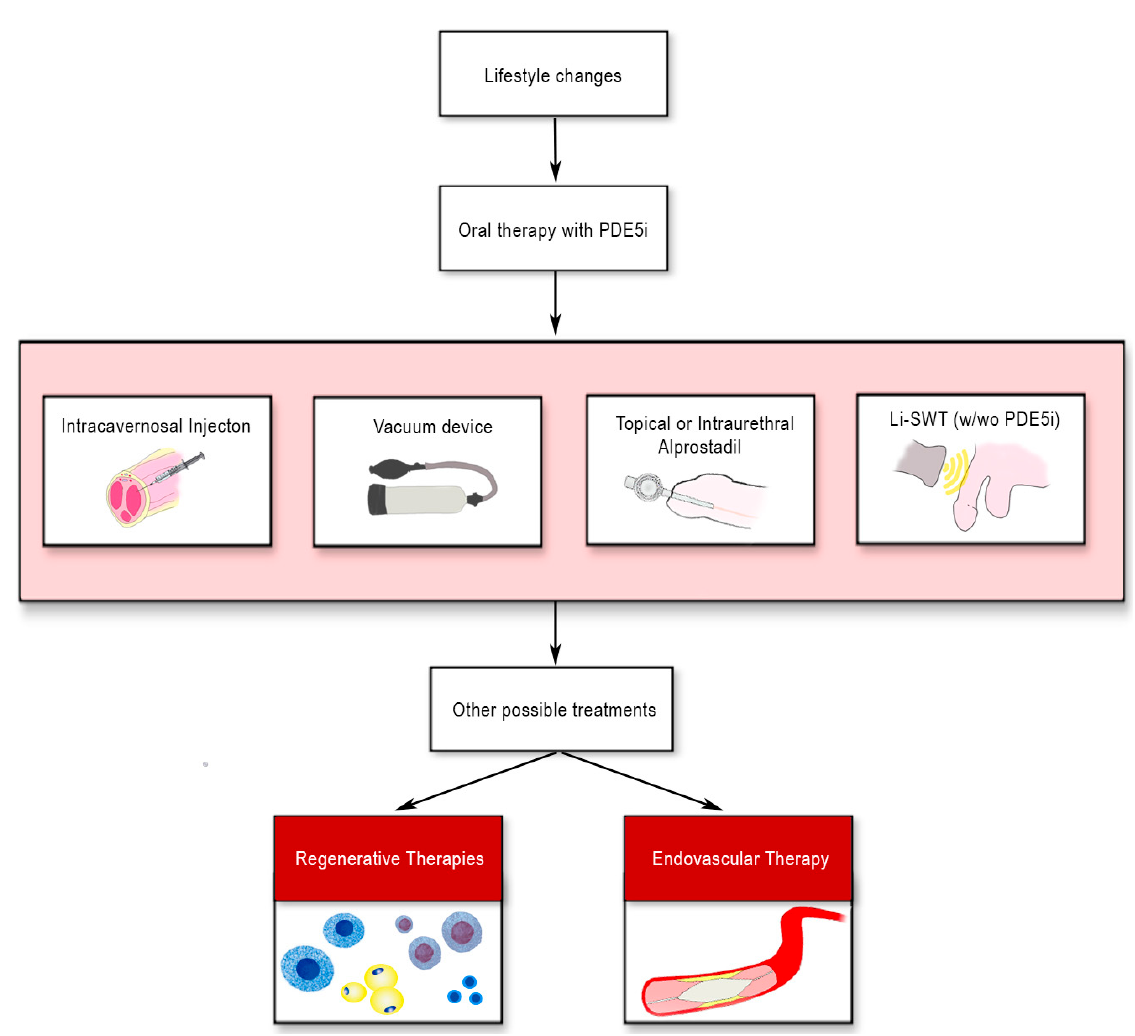
Figure 1. Current approaches to the treatment of erectile